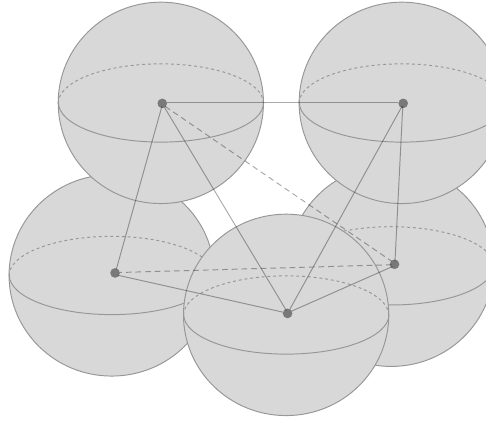
Figure 26 . The (cid:12)rst step of a swiss cheese construction: the manifold is triangulated, and spherical holes are opened up at the vertices of the